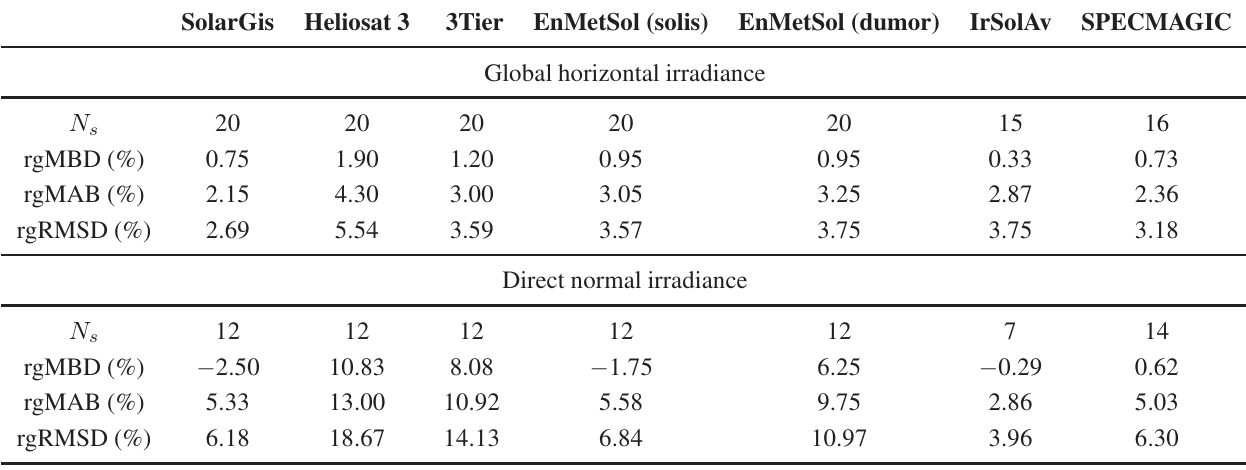
Table 6. General statistics for the validation of global horizontal and direct normal irradiance estimation, Ineichen, 2011 [35]. The results for the present work are given as the last column for comparison. N is the number of stations used for the comparison for each product. s SolarGis Heliosat 3 3Tier EnMetSol (solis) EnMetSol (dumor) IrSolAv SPECMAGIC Global horizontal